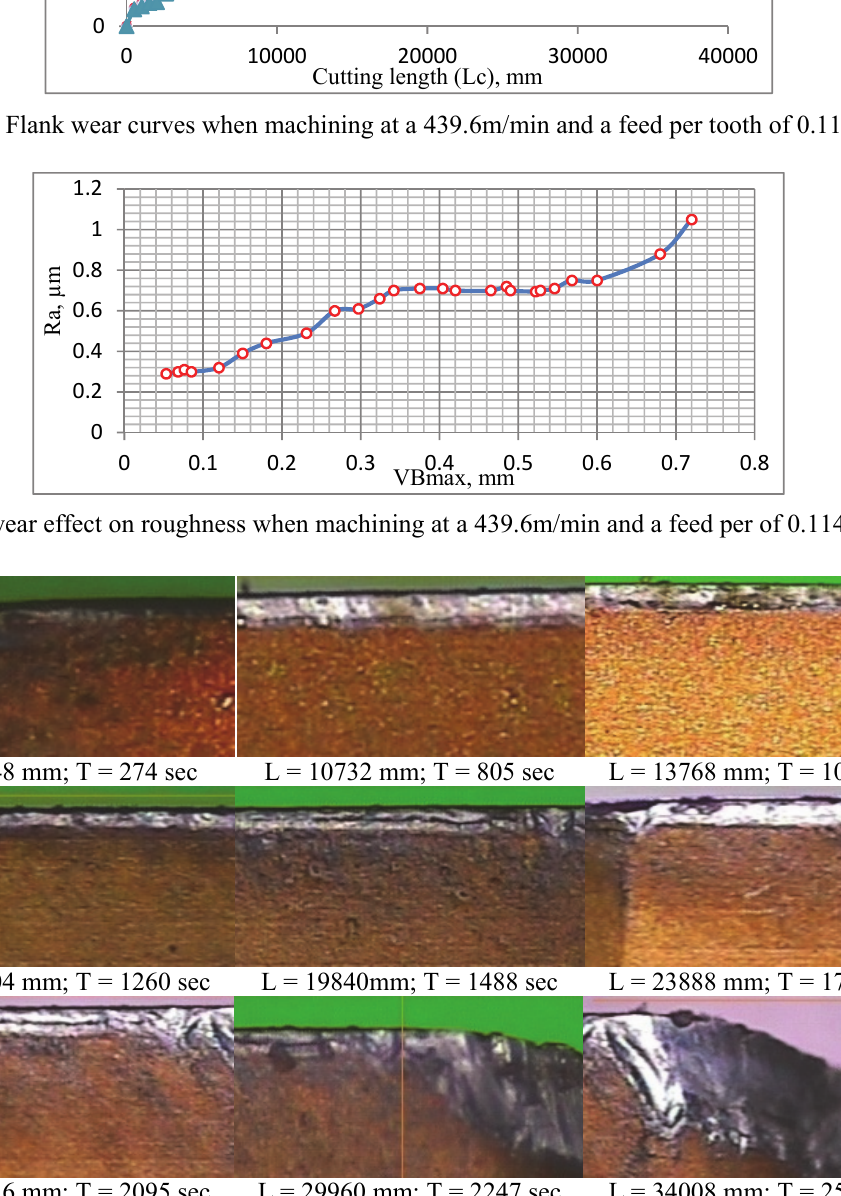
Fig. 16. Micrograph of insert after different machining